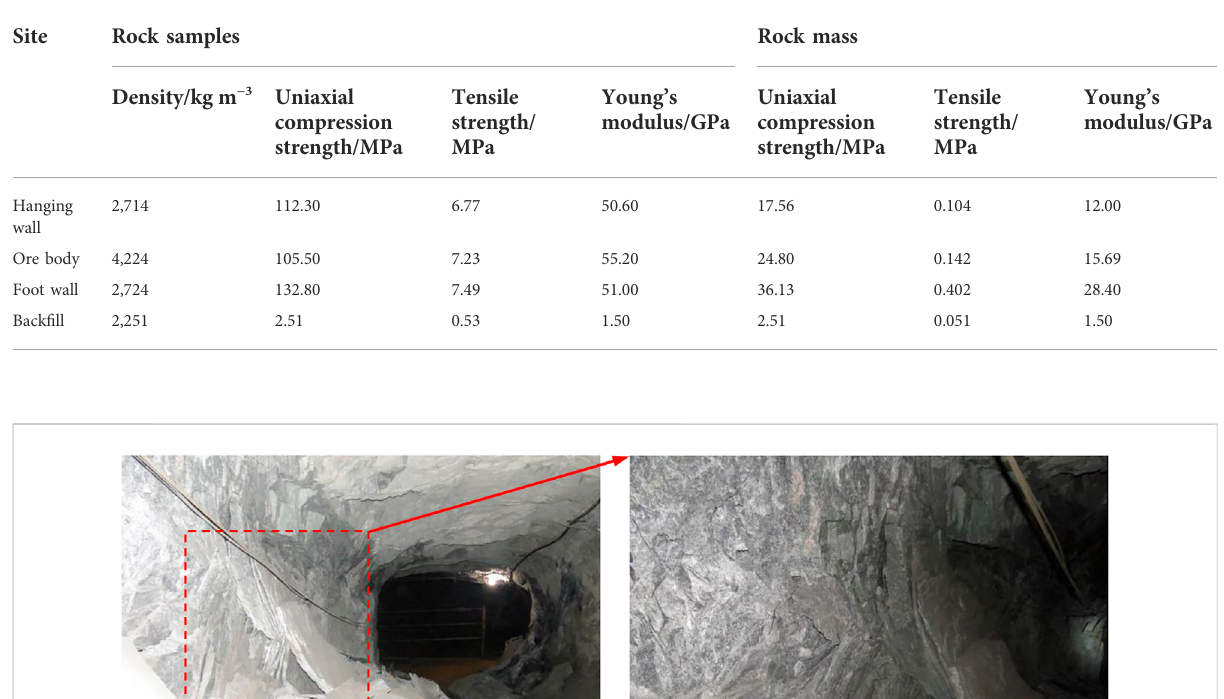
TABLE 1 Mechanical parameters of rock samples and rock mass.